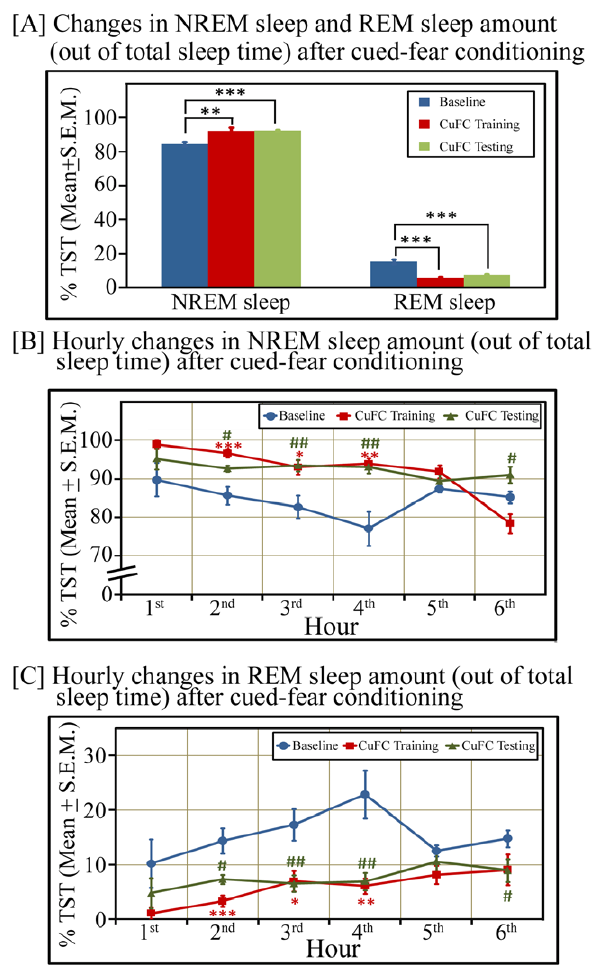
Figure 4. Changes in sleep architecture (out of total sleep time) after cued fear conditioning during the lights-on phase. [A] Percent changes in NREM sleep and REM sleep amount after CuFC training and testing compared to baseline day. Out of total sleep time, % NREM sleep amount significantly increased on CuFC training (p , 0.01; F (1,15) =9.86) and testing (p , 0.001; F (1,15) =31.94) days, while % REM sleep amount significantly decreased on CuFC training (p , 0.001; F (1,15) =46.78) and testing (p , 0.001; F (1,15) =31.94) days compared to baseline day. Hourly percent time (out of total sleep time) spent in [B]